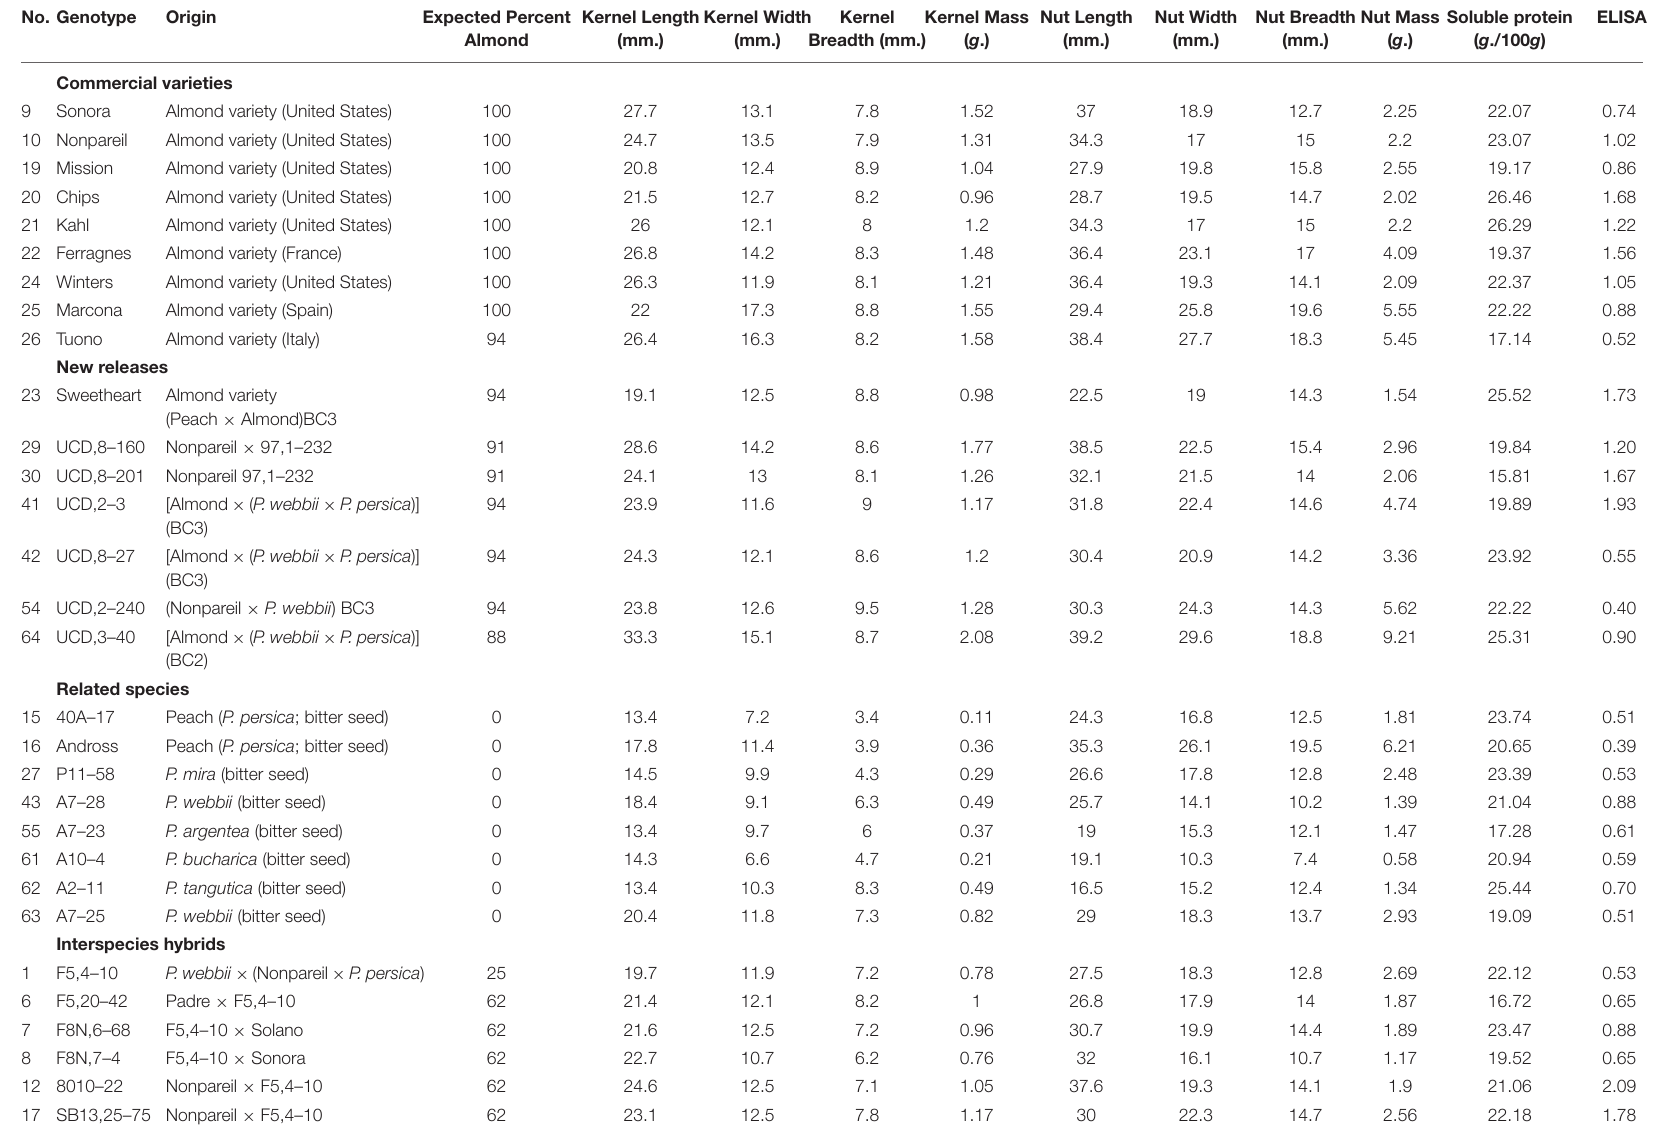
TABLE 1 | Nut and kernel characteristics, including ELISA immunoreactivity values, for an intra- and interspecific almond breeding germplasm. No.